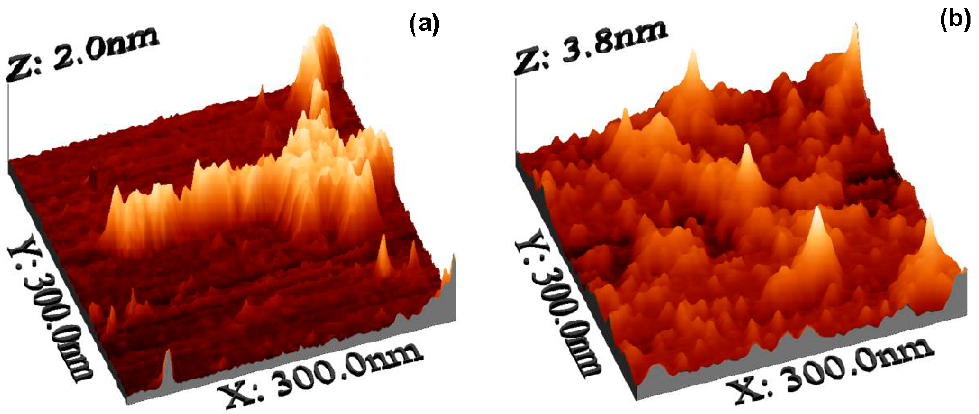
Figure 2. Pseudo ‐ 3D AFM images of silica ‐ lignin matrix ( a ) and product following enzyme Figure 2. Pseudo-3D AFM images of silica-lignin matrix ( a ) and product following enzyme immobilization ( b ) for scanning at 300 nm × 300 nm. immobilization ( b ) for scanning at 300 nm × 300